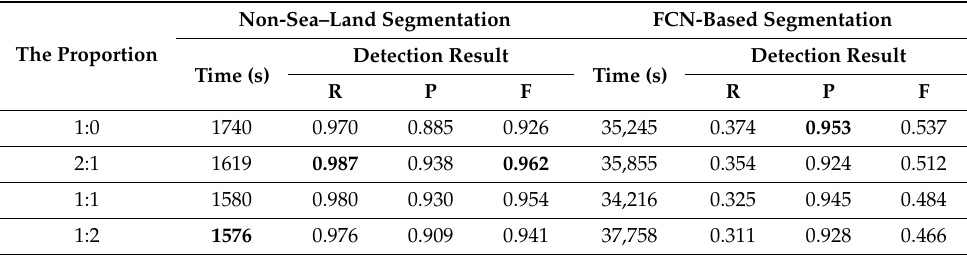
Table 8. Results and time spent of detection of the first JL-1 image.